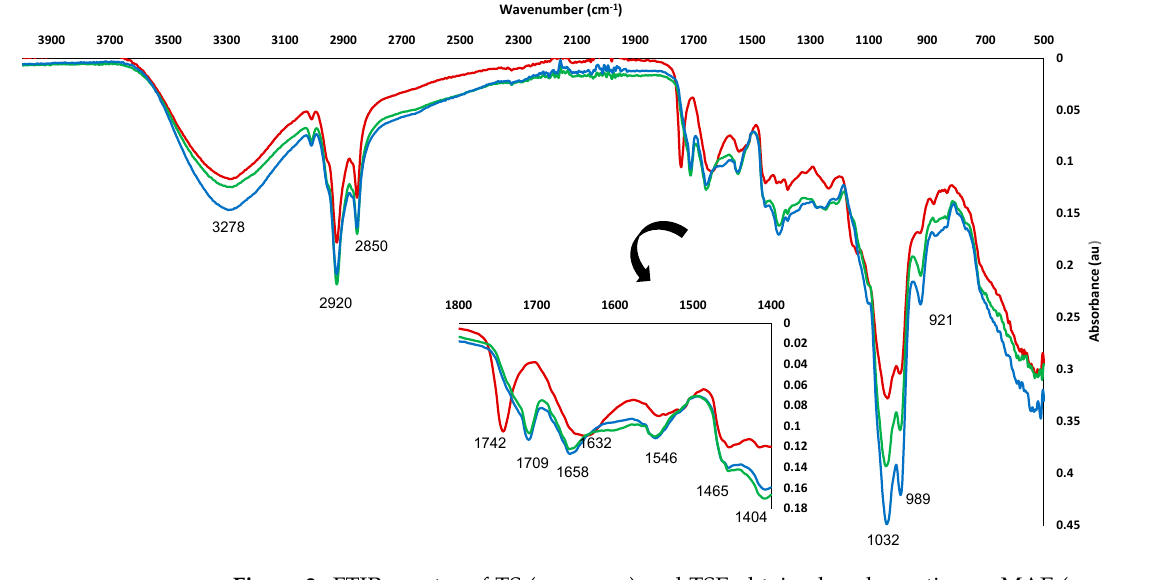
Figure 3. FTIR spectra of TS ( −−−−− ) and TSE obtained under optimum MAE ( −−−−− ) and UAE ( −−−−− ) conditions.